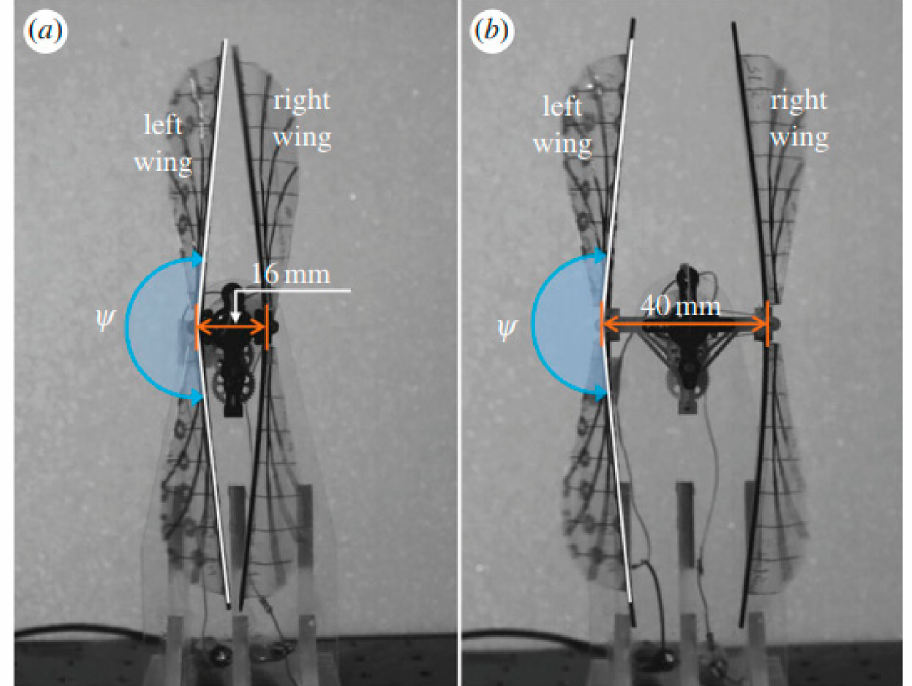
Figure 3. Composite images of the flapping wings at the end of up- and down-strokes. ( a ) The clap-and-fling effect is strong with wing distance of 16 mm (0.64 c m ); ( b ) The clap-and-fling effect is almost diminished with wing distance of 40 mm (1.6 c m ) Reprinted from Ref.